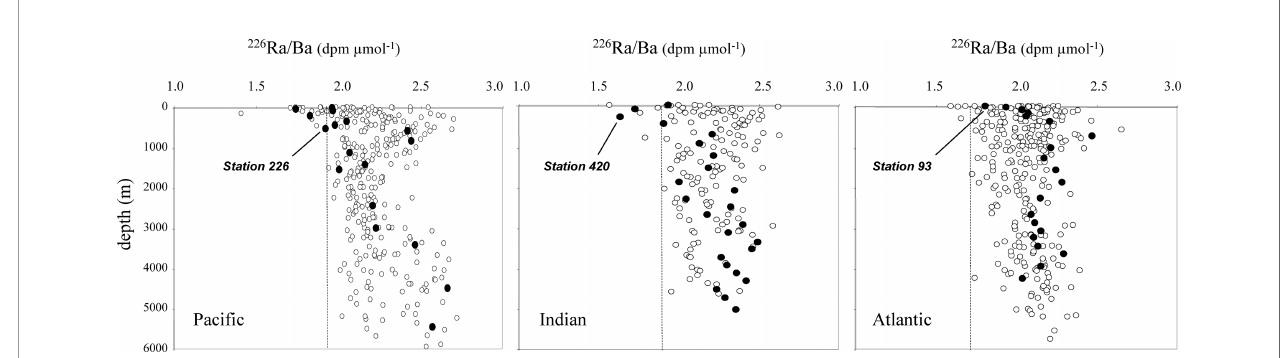
FIGURE 11 | Compilation of the vertical distributions of 226 Ra/Ba ratios reported in the Paci fi c, Indian and Atlantic Oceans during the GEOSECS program (open circles). Ratios found at station #226 (Paci fi c Ocean), station #420 (Indian Ocean) and station #93 (Atlantic Ocean) are underlined on the graphs (closed circles). The vertical line is placed to highlight the lower 226 Ra/Ba ratios found in the upper water column (left of the line) at